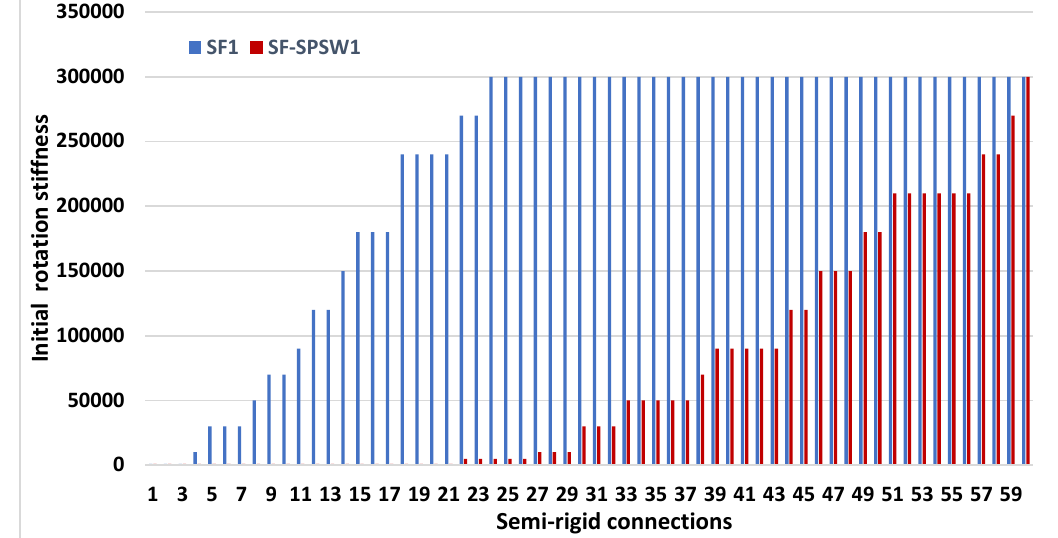
Figure 19. The proportion of the semirigid connections.